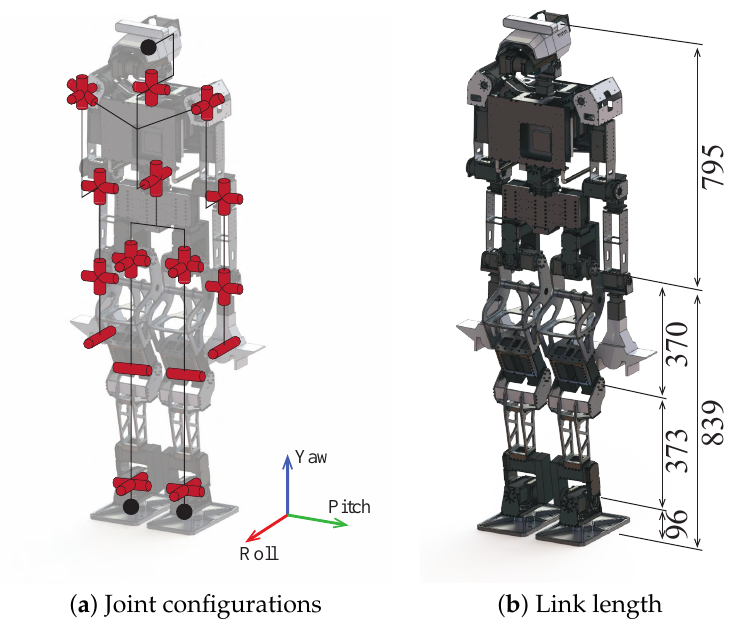
Figure 3. Kinematic structure of